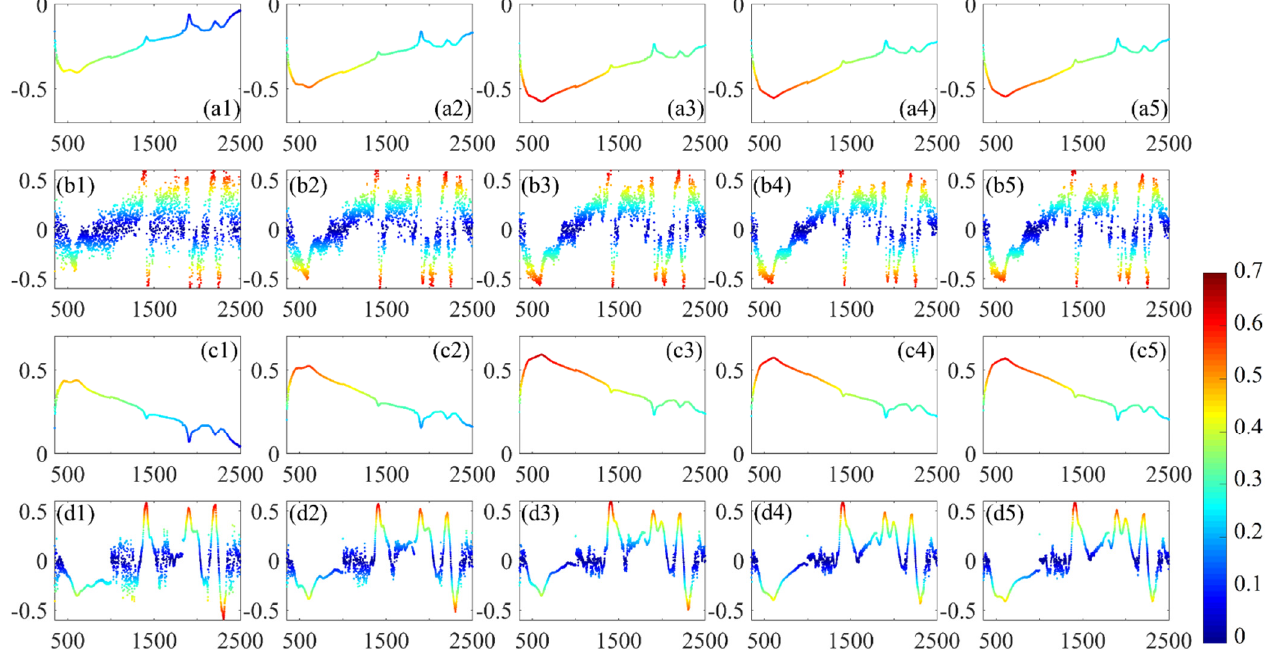
Figure 8. ( a1 – a5 ) show the Pearson correlation coefficient between the spectral reflectance (R) and soil N content of Dt1 to Dt5; Correspondingly ( b1 – b5 ) show the Pearson correlation coefficient between the R’ spectra and soil N content of Dt1 to Dt5; ( c1 – c5 ) show the Pearson correlation coefficient between the ln(1/R) spectra and soil N content of Dt1 to Dt5; ( d1 – d5 ) show the Pearson correlation coefficient between the CR spectra and soil N content of Dt1 to Dt5. Axis X indicates the spectral region (unit: nm). Axis Y indicates the Pearson correlation coefficient. The color bar indicates the absolute value of the correlation coefficient. Table 1. Sensitive bands to soil N content.